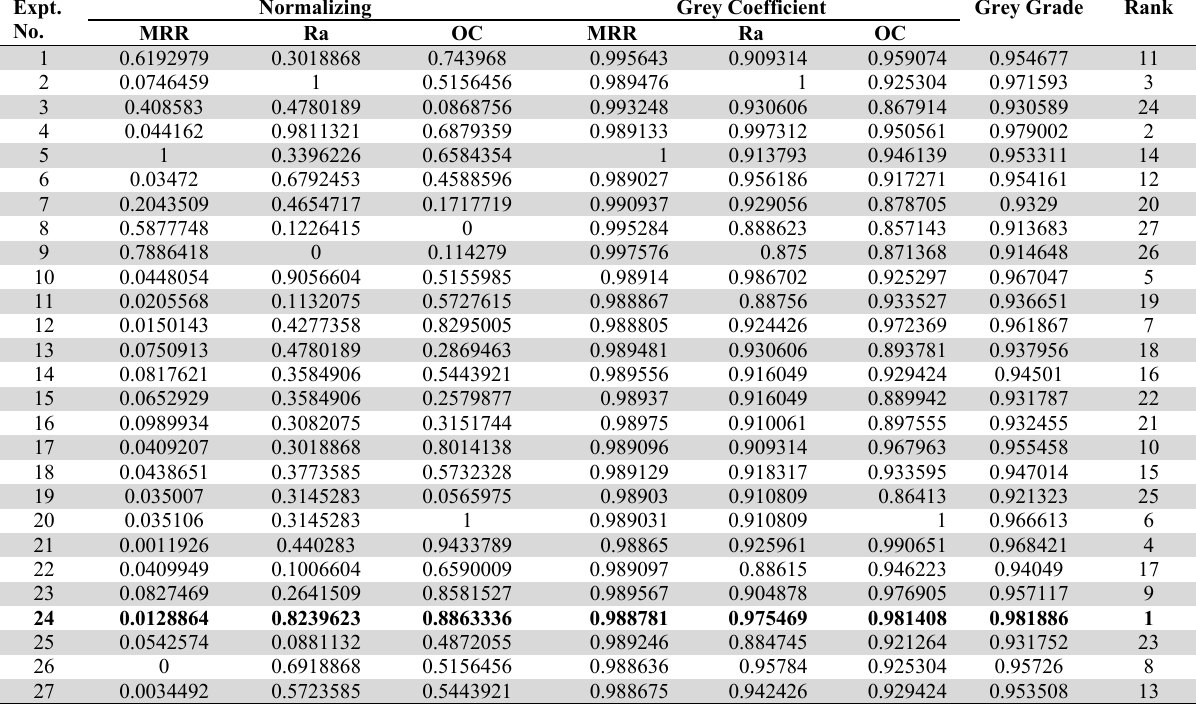
Grey relational coefficients and grades Expt. No.